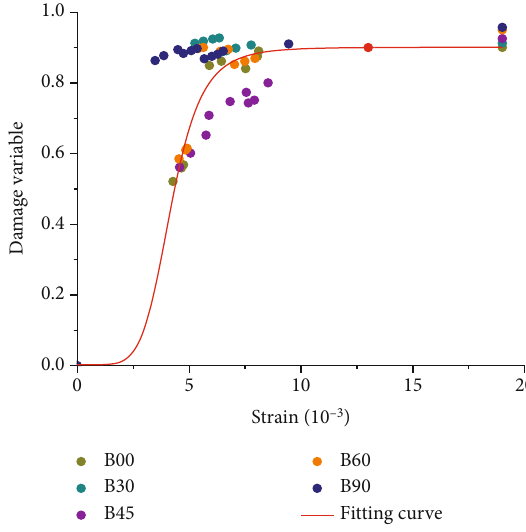
Figure 17: Damage evolution curve for specimens of group B.